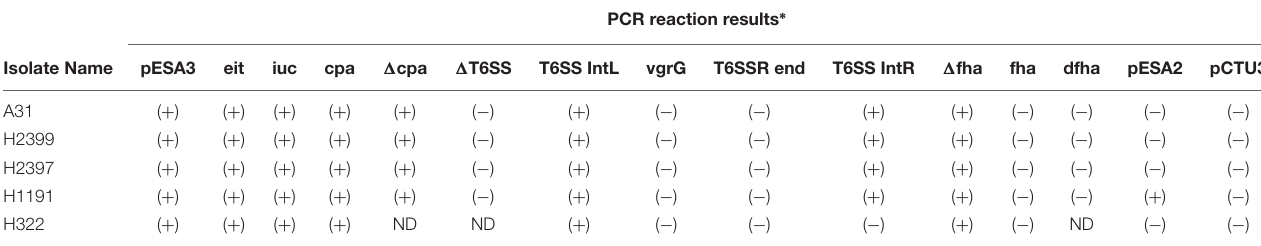
FIGURE 3 | Phylogenetic analysis of C. sakazakii strains of different ST: Allelic variations in conserved genes spanning the whole genome were used for this analysis. Alleles present in homologs of 1000 C. sakazakii strain BAA-894 chromosomal loci (reference gene set for this analysis) in 44 genomes were detected by BLAST-based workflow (Tall et al., 2015). SNPs in 37,711 positions in these genomes were concatenated and the cladogram was built using Neighbor-Joining algorithm available on MEGA7 phylogenetic suite (Kumar et al., 2016). The bootstrap consensus (values located on the nodes) in the tree are inferred from 500 replicates. 44 genomes separated into eight STs and multiple clusters reflecting microarray-based clusters. Five ST83 isolates group together with A31 showing some differences in the cluster confirming other results. TABLE 3 | Plasmid typing results for the C. sakazakii serotype ST 83 strains analyzed in this